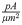
Increase of the Na+ concentration in the intracellular compartment, [Na+]i, during a constant extracellular glutamate concentration for different values of the maximal pump currents of the Na+/Ca2+ exchanger (INCXmax), the glutamate transporter (IGluTmax), the Na+/K+-ATPase (INKAmax).The astrocytic compartment was stimulated for 200 seconds with a constant extracellular glutamate concentration of 100 μM. The surface volume ratio (SVR) was set equal to 1 μm-1, which corresponds to astrocytic compartments close to the soma. a [Na+]i after 200 seconds with respect to its resting concentration ([Na+]rest = 15 mM, Δ Na+ = [Na+]End—[Na+]rest) for a maximal pump current of the Na+/Ca2+ exchanger (INCXmax) equal to 0 pAμm2 (left) or equal to 1 pAμm2 (right) and different values of the maximal pump current of the glutamate transporter (IGluTmax) and the Na+/K+-ATPase (INKAmax). b Time to reach saturation for a maximal pump current of the Na+/Ca2+ exchanger (INCXmax) equal to 0 pAμm2 (left) or equal to 1 pAμm2 (right) and different values of the maximal pump current of the glutamate transporter (IGluTmax) and the Na+/K+-ATPase (INKAmax). The time to saturation was defined as the time required for the intracellular Na+ concentration to remain on a constant concentration.